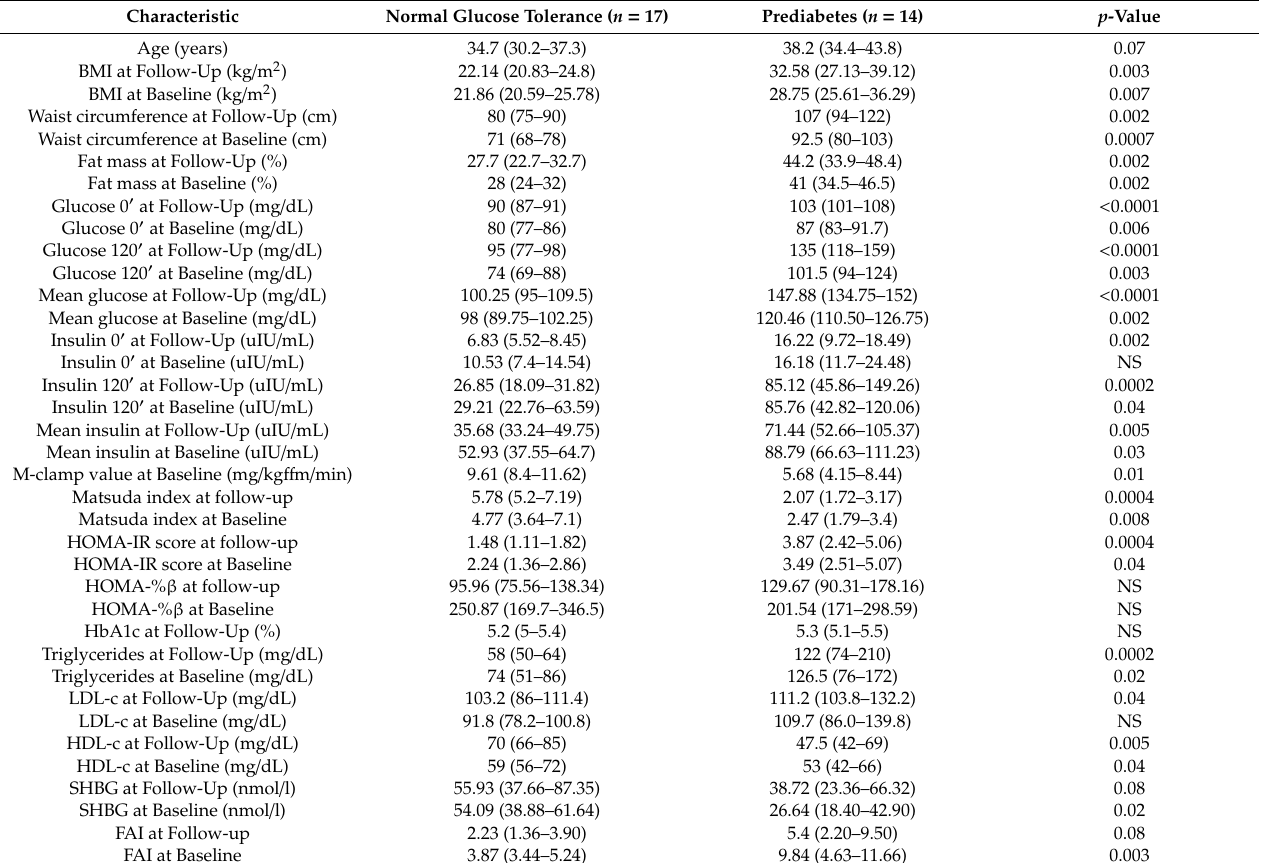
Table 7. Characteristics of the participants according to glucose